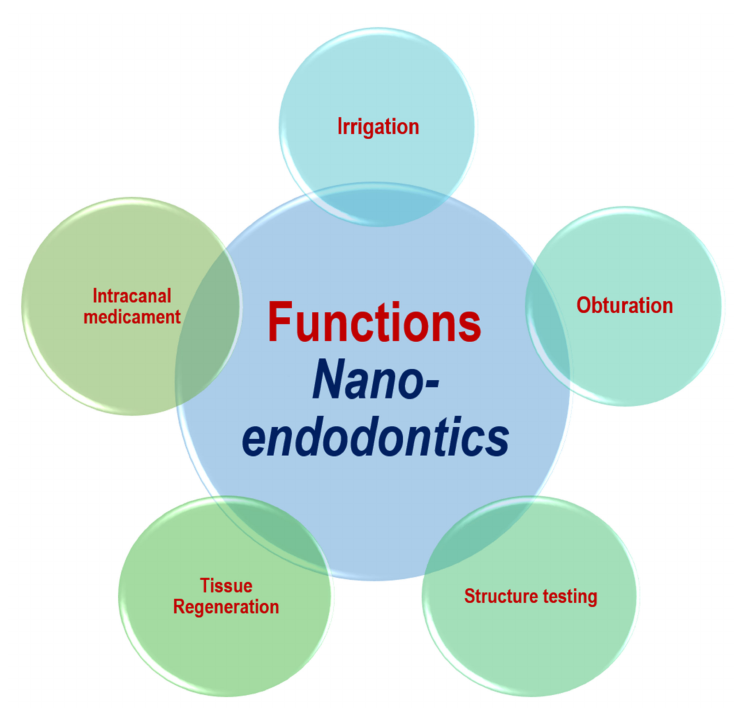
Figure 2. Functional applications of nanotechnology in